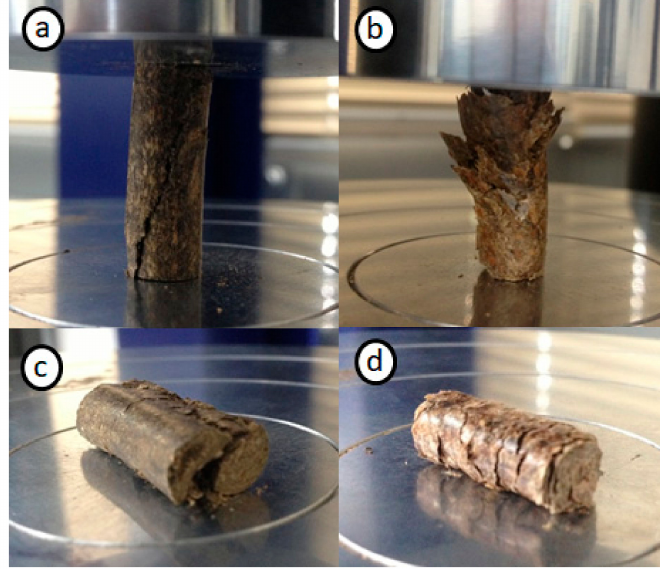
Figure 5. ( a ) Axial failure by shear (sunflower pellets), ( b ) axial failure by delamination (mixed wood pellets), ( c ) diametral failure by shear (sunflower pellets), and ( d ) diametral failure by delamination (mixed wood